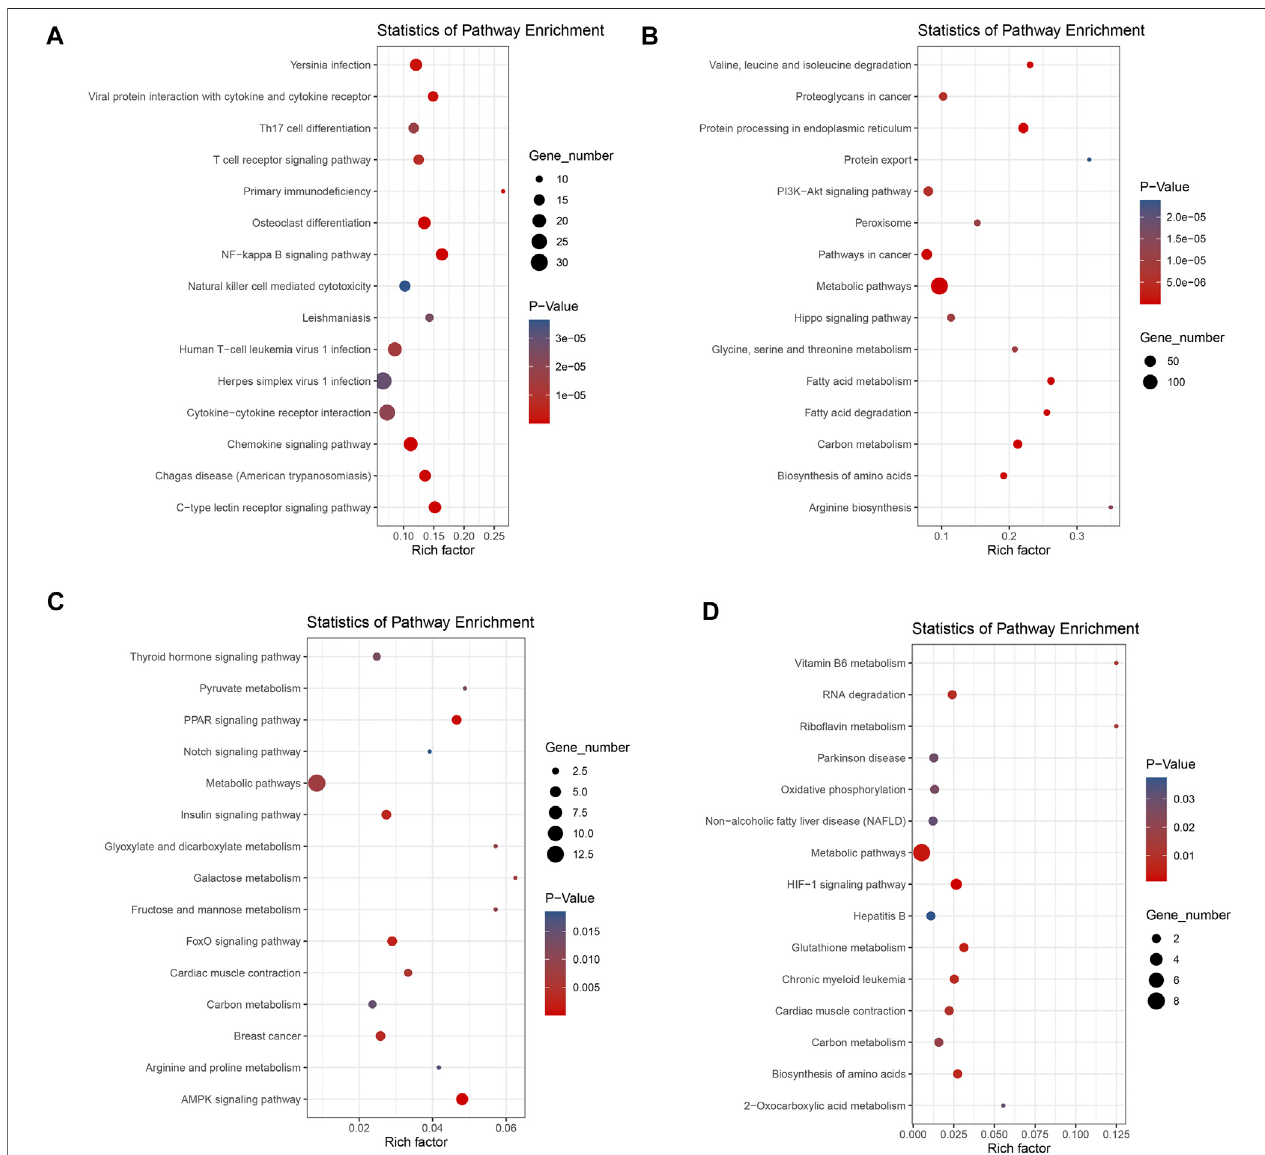
FIGURE 3 | Bubble plots showing functional pathways of KEGG enrichment: The top 15 pathways shown in (A) pathways of up-regulated genes of liver; (B) pathways of down-regulated genes of liver; (C) pathways of up-regulated genes of muscle, and (D) pathways of down-regulated genes of muscle. Up- and down-regulation refers to gene expression in DP relative to